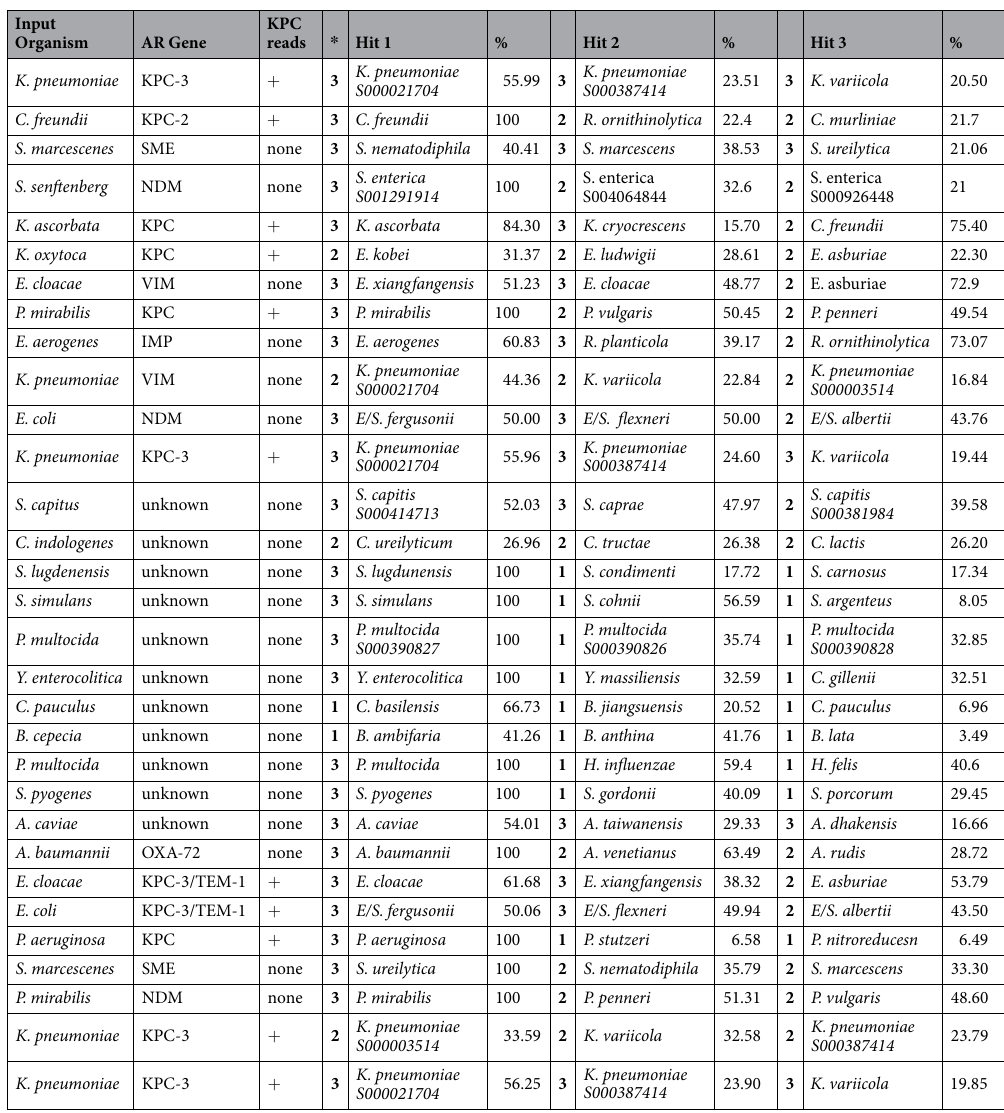
Table 2. Taxonomic classification of 16S sequencing reads and detection of KPC genes from mock clinical blood culture samples. * Bold indicate number of databases a reference species